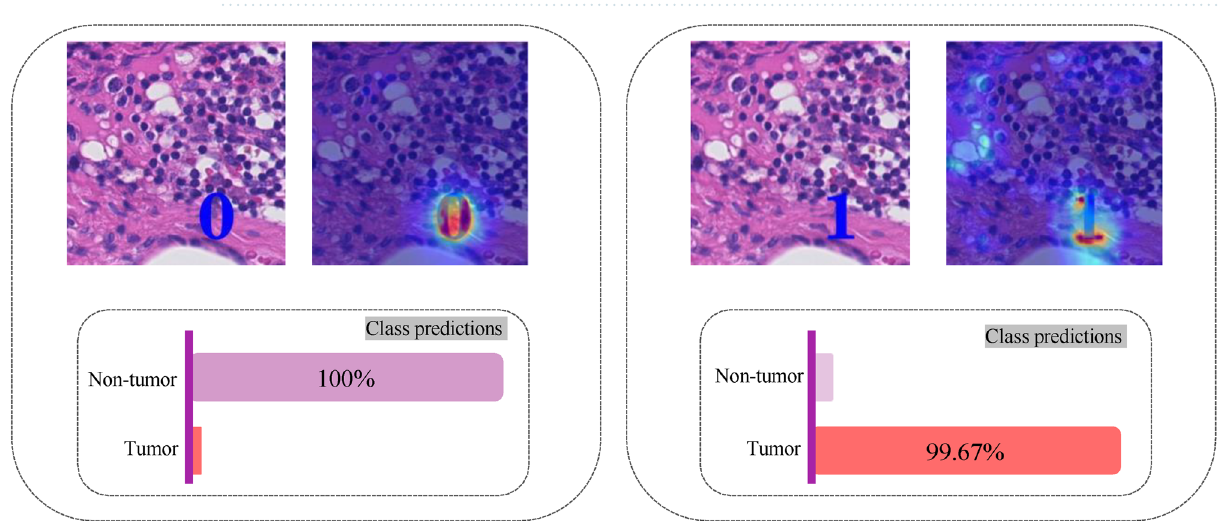
Figure 4. KimiaNet trained using Scenario 3 when tested with a tumorous OOD patch with different class labels overlaid and their corresponding GradCAM heatmaps. (left) When false label (0: non-tumor) has been overlaid on the image. According to the class prediction of the network, the network has thoroughly paid attention to the overlaid digit and misclassified the image with its misleading shortcut. (right) When the true label (1: tumor) has been overlaid. The network, by focusing on the shortcut, classified the patch with a high degree of certitude.